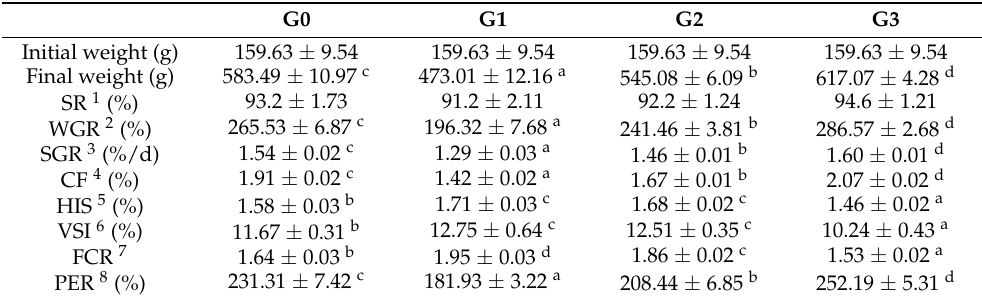
Table 3. Effect of fish meal replaced by unfermented and/or fermented soybean meal on growth performance of the juvenile coho